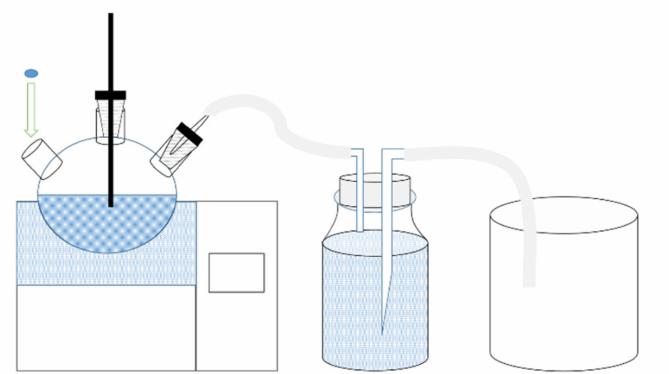
Figure 1. Schematic diagram of hydrogen production performance test